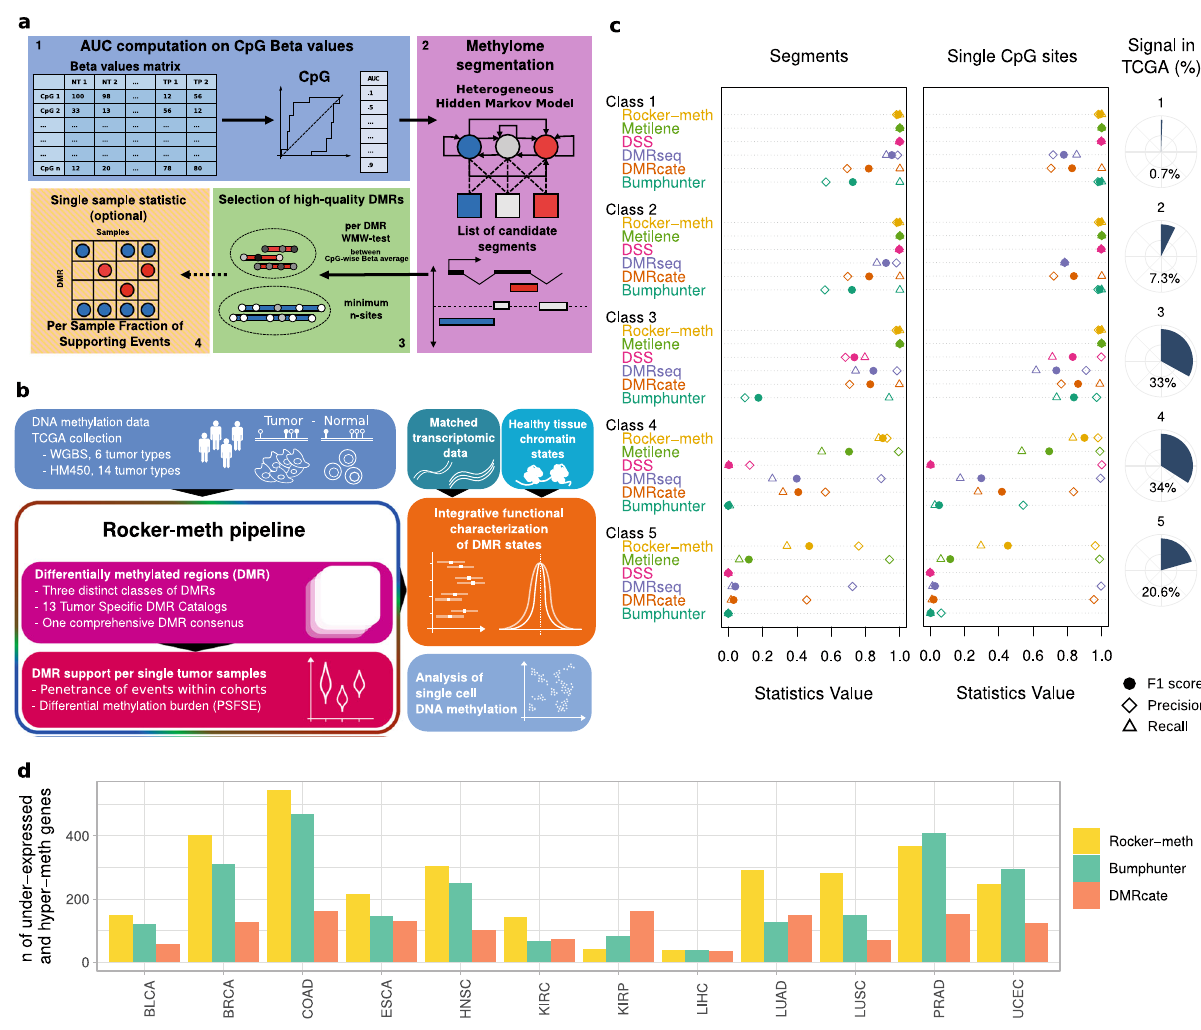
Fig. 1 Rocker-meth study design and performance on synthetic datasets. a The Rocker-meth method involves four main steps: (1) computation of Area Under the Curve (AUC) values of methylation levels (i.e., beta values) in tumor versus normal samples; (2) segmentation of AUC values by a tailored heterogeneous Hidden Markov Model (HMM); (3) fi lters on segments features including intra-segment homogeneity and number of CpG sites; (4) identi fi cation of sample speci fi c DMRs by Z-score statistics (optional). b To showcase Rocker-meth, we applied it to multiple DNA-methylation cancer datasets, generated using array (HM450) and sequencing (WGBS and single-cell DNA-methylation) data. We also exploited orthogonal omics data (gene expression data from TCGA and ENCODE chromatin states) to evaluate its capability of capturing biologically relevant features. c Comparative study in synthetic DNA methylation datasets. Right: Dot chart summarizing segment-wise (left) and site-wise (right) precision (diamonds), recall (triangles) and F1 ( fi lled circles) statistical measures for Bumphunter, DMRcate, DMRseq, DSS, Metilene, and Rocker-meth in the fi ve WGBS synthetic datasets. Right: distribution of the differences of per site percentage of methylation (beta) between tumor and normal samples for all differentially methylated sites across 14 tumor types (TCGA datasets). The range of beta difference classes is de fi ned on synthetic datasets and termed from class 1 (highest signal-to-noise ratio) to class 5 (lowest signal-to-noise ratio). The fraction of emulated TCGA data is reported as pie chart. d Bar plots of the number of hyper-DMRs in promoter-TSS, 5 ′ UTR, or fi rst intron of under-expressed genes. Bars refer to the number of events detected by Rocker-meth, Bumphunter, and DMRcate across the different tumor types. DMR differentially methylated region, TCGA the cancer genome atlas, PSFSE per sample fraction of supporting events, WGBS whole genome bisul fi te sequencing, HM450 Illumina 450k array, TP tumor primary, NT normal adjacent